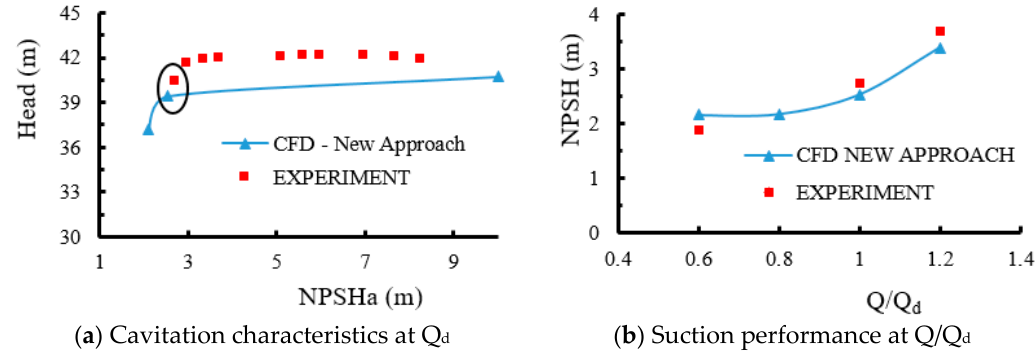
Figure 11. Suction performance prediction and comparison.